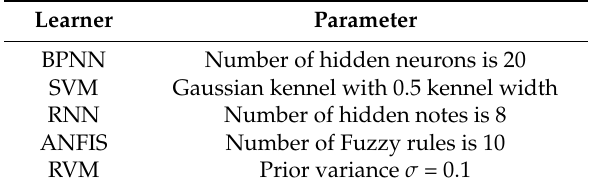
Table 3. Parameter settings for each member algorithm in the ensemble.